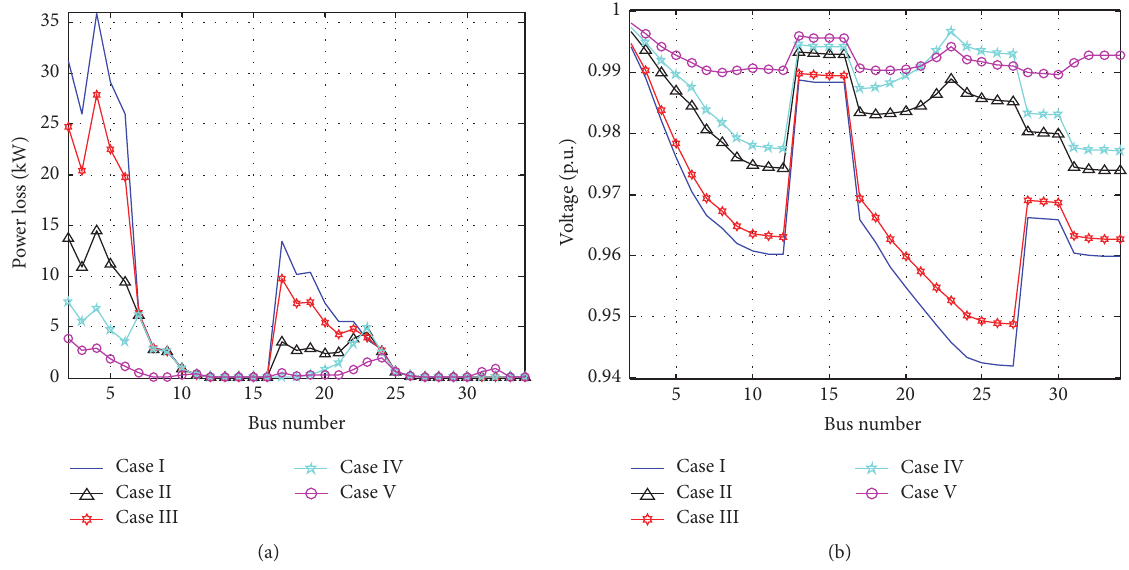
Figure 3: (a) Comparison of line losses for different cases in 34-bus system. (b) Comparison of voltage profile for different cases in 34-bus